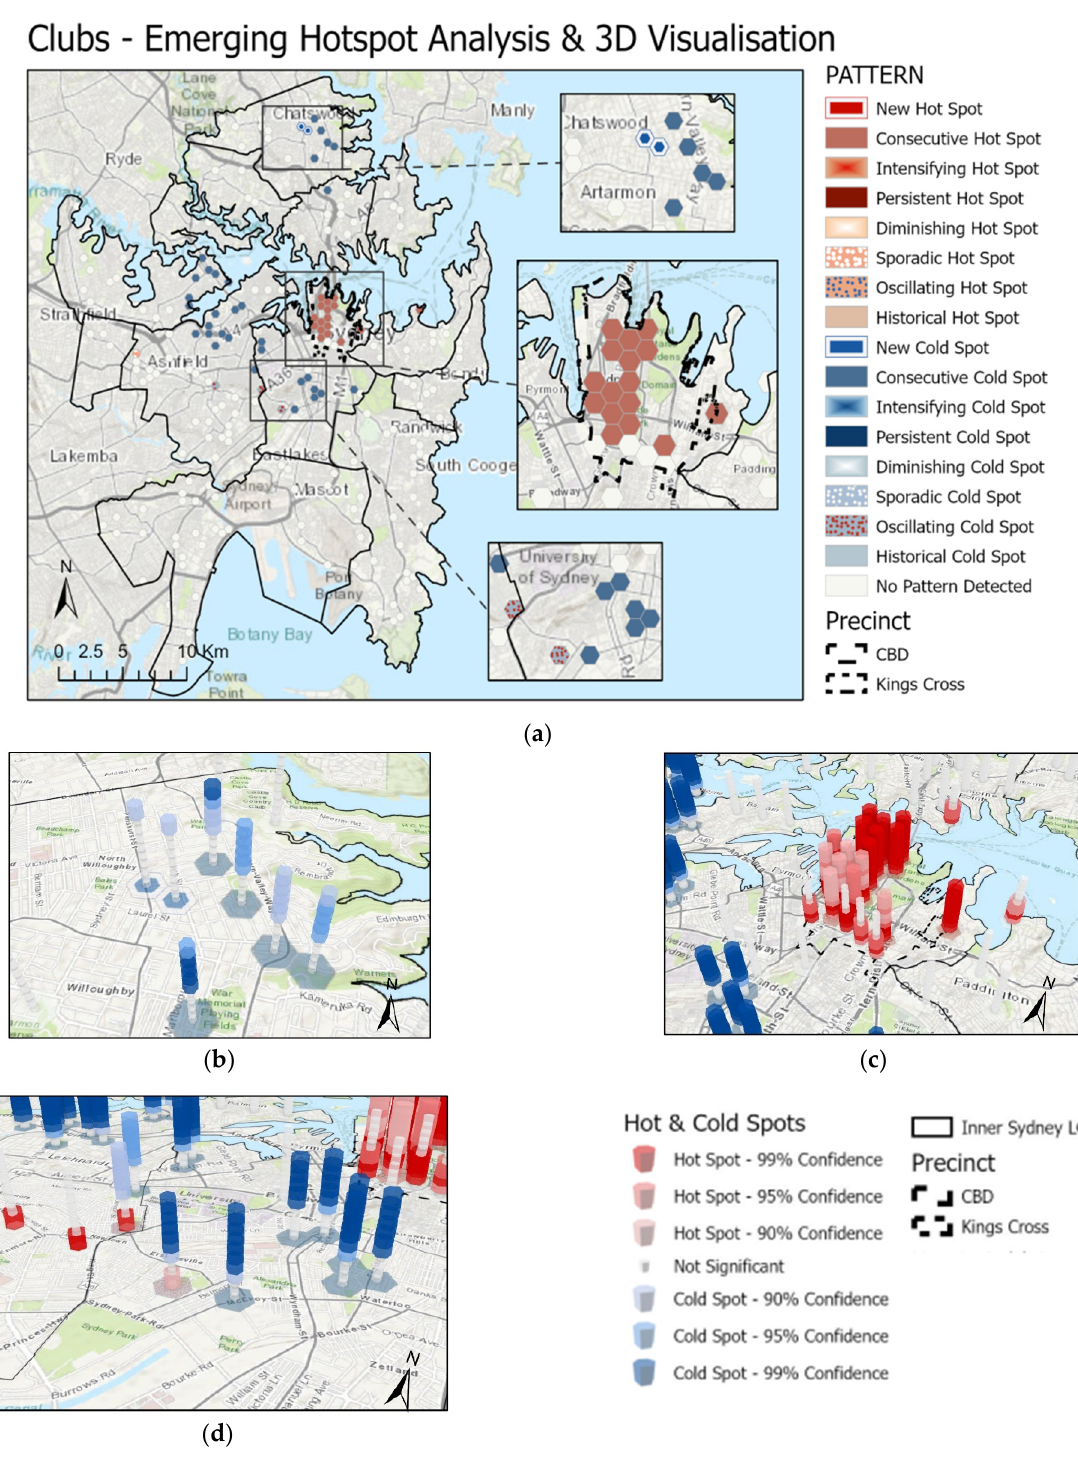
Figure 14. ( a ) Licensed club spatio ‐ temporal analysis 2012–2021; ( b ) Club space ‐ time cube 3D visualisation northern section; ( c ) Club space ‐ time cube 3D visualisation CBD section; ( d ) Club space ‐ time cube 3D visualisation southern section.